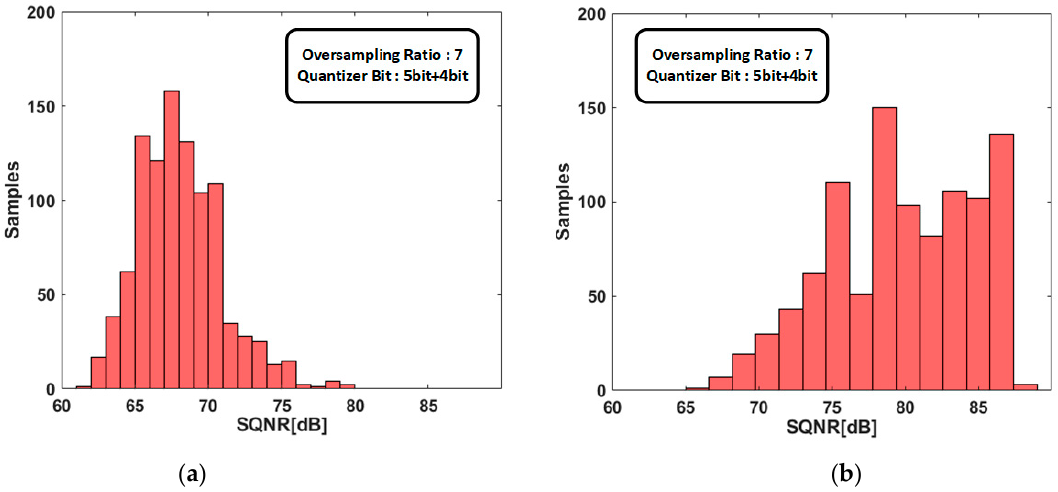
Figure 3. The SQNR histogram for different open-loop gain of inter-stage amplifier with 5% variation and no filter calibration: ( a ) the open-loop gain of 40 dB and ( b ) the open-loop gain of 60 dB.